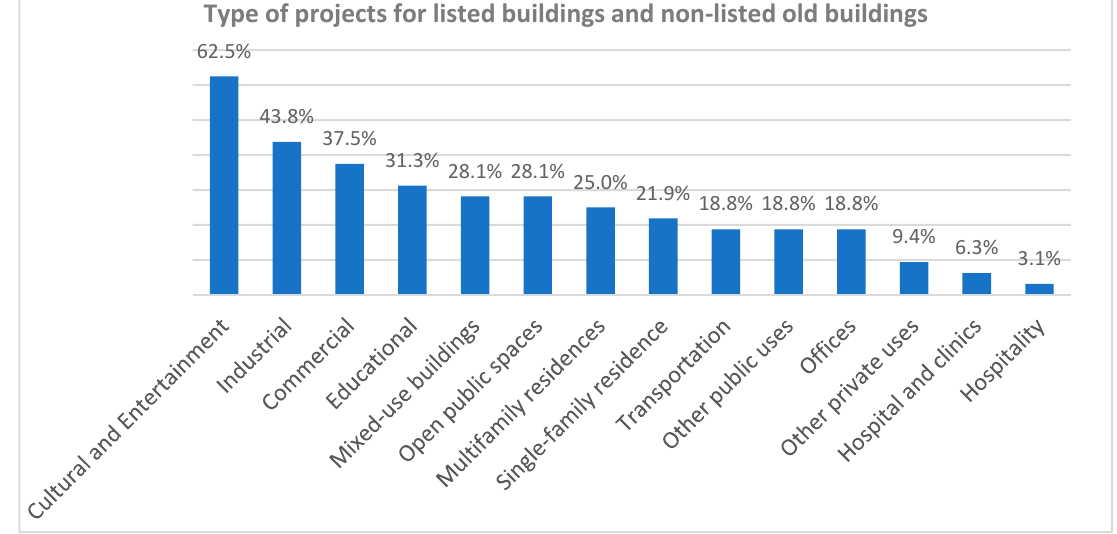
Figure 10. Types of projects for listed buildings and non-listed old buildings worked in the last 12 months.